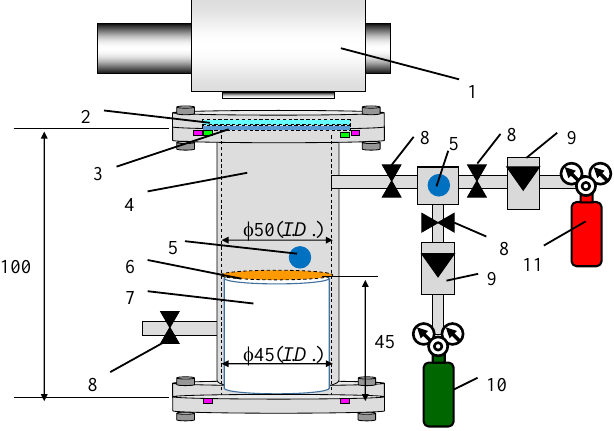
Figure 13. Experimental setup for CO 2 reduction [49,50].